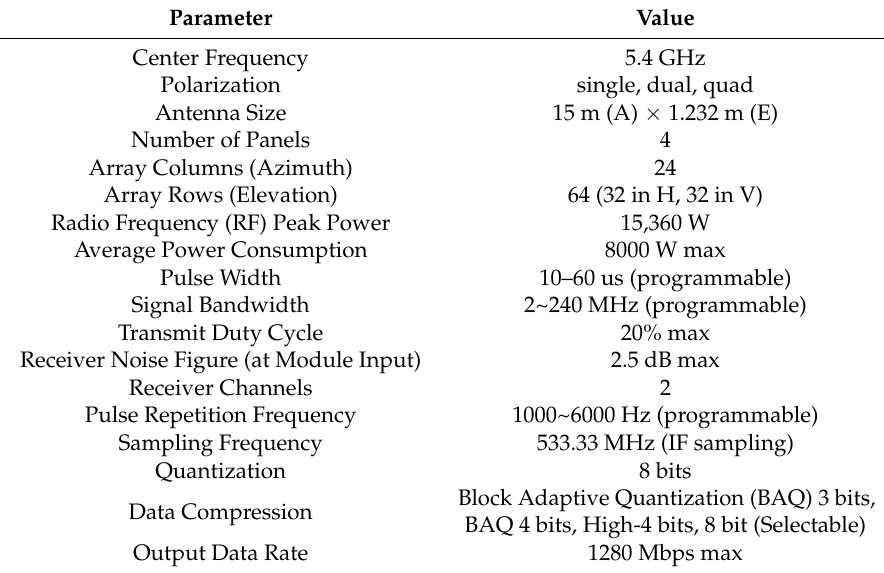
Table 2. Synthetic Aperture Radar (SAR) payload key